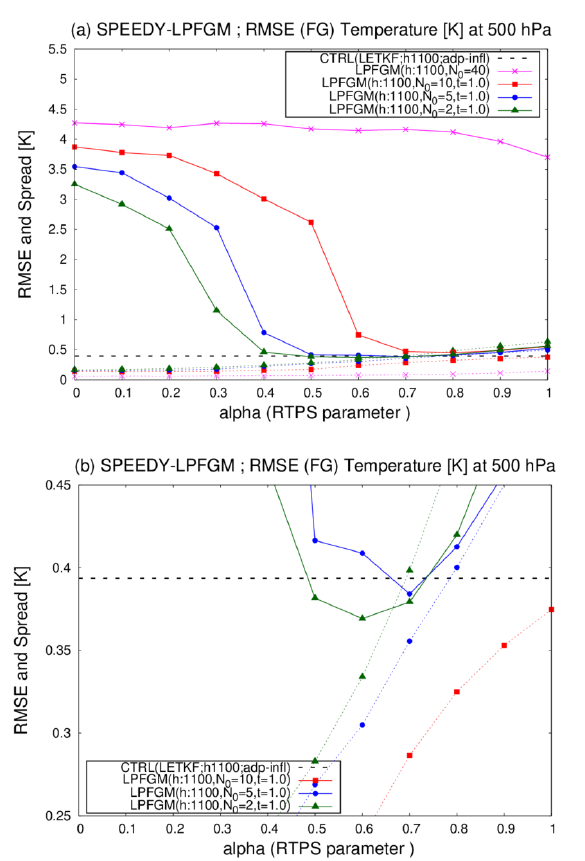
Figure 10. Similar to Fig. 5 but showing the LPFGM experiments with the RAOB and 1100km localization scale. Magenta, red, blue, and green lines are the LPFGM experiments with N 0 = 40, 10, 5, and 2, respectively. Forgetting factor τ is fixed at 1.0. Dashed black lines represent the RMSE of the LETKF (0.4762K); (b) enlarges (a) for the range of the RMSE of 0.25–0.45.